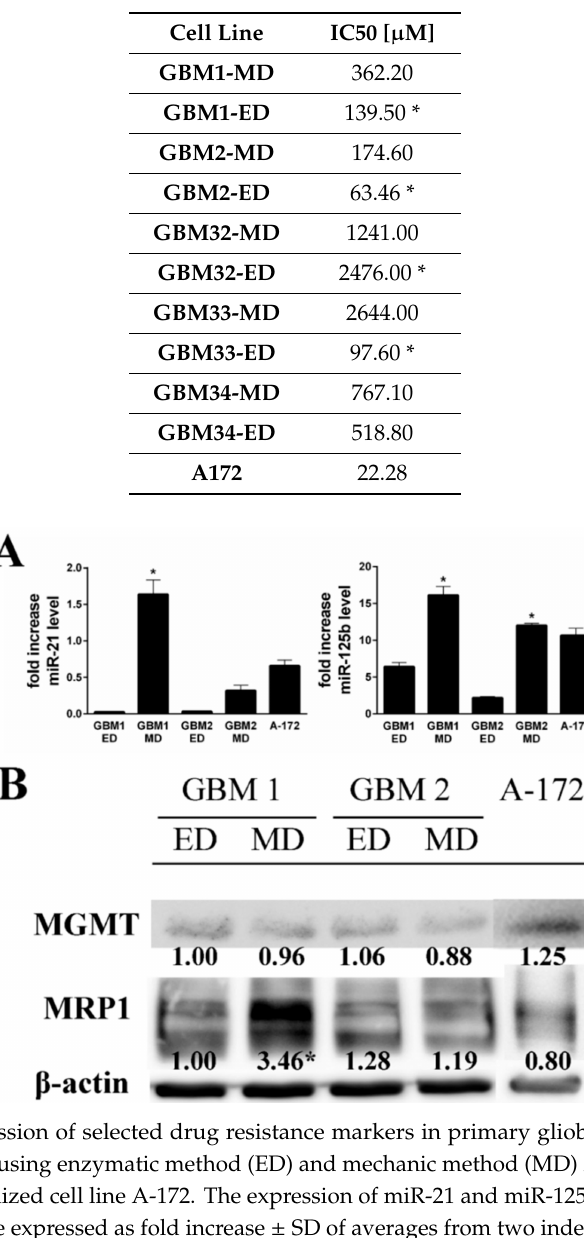
Table 2. The concentration inducing 50% decrease of cell viability (IC50) values of temozolomide (TMZ) treatment in primary glioblastoma cells (GBM1, GBM2, GBM32, GBM33, and GBM34), obtained using enzymatic dissociation (ED) and mechanic dissociation (MD) from appropriate human samples after 48 h of incubation. Results were compared with stabilized cell line A172. * p < 0.05 enzymatic vs. mechanic dissociation; data are expressed as average ± SD.